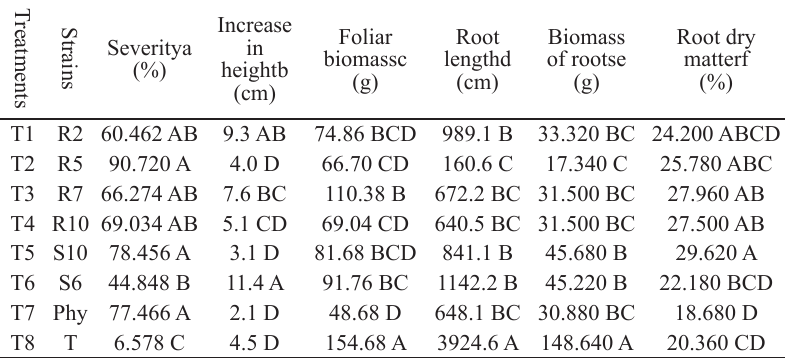
Table 4. Measurement of avocado variables with the comparison test of means (Tukey) of treatments inoculated with strains Pseudomonas spp. against P. cinnamomi, under greenhouse conditions.